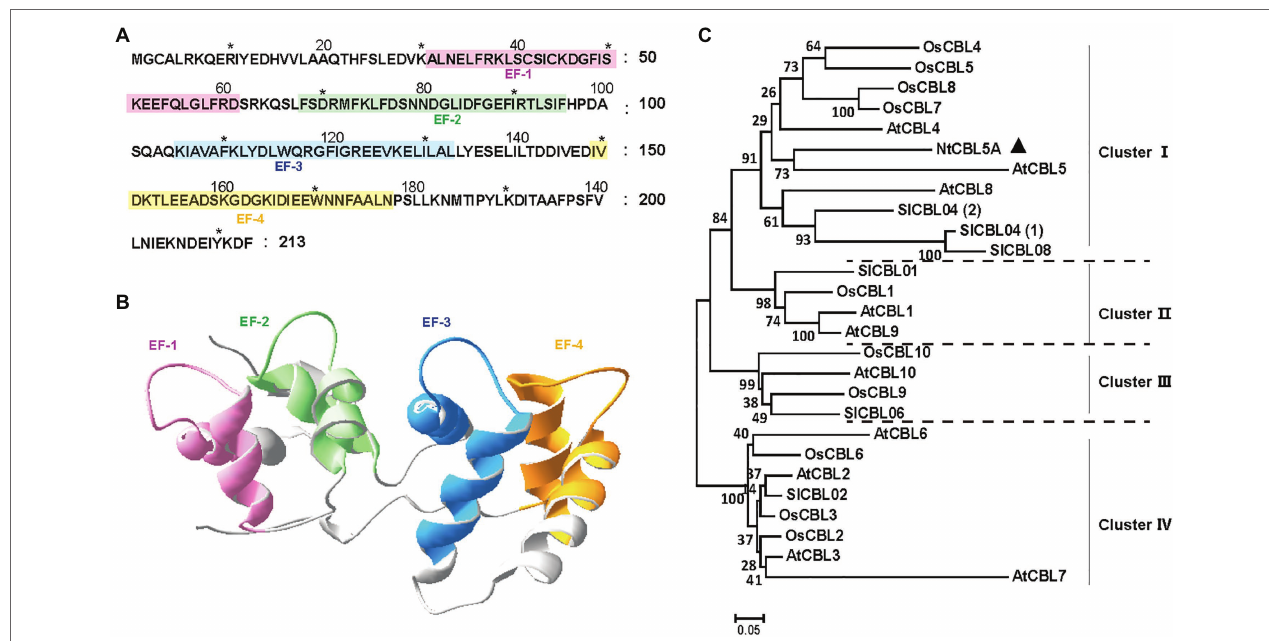
FIGURE 1 | Structure and phylogenetic relationship of NtCBL5A. (A) Amino acid sequence of NtCBL5A and the positions of four EF-hands predicted by SMART. (B) The 3D structure of NtCBL5A predicted by SWISS-MODEL. (C) Phylogenetic analysis of NtCBL5A and all known CBL members from Arabidopsis thaliana , Oryza sativa , and Solanum lycopersicum . The amino acid sequences of AtCBLs, OsCBLs, and SlCBLs were downloaded from TAIR (https://www.arabidopsis.org/), NCBI (https://www.ncbi.nlm.nih.gov/), and Sol Genomics Network (https://solgenomics.net/), respectively. The phylogenetic tree was constructed by MEGA6 using the Neighbor-Joining